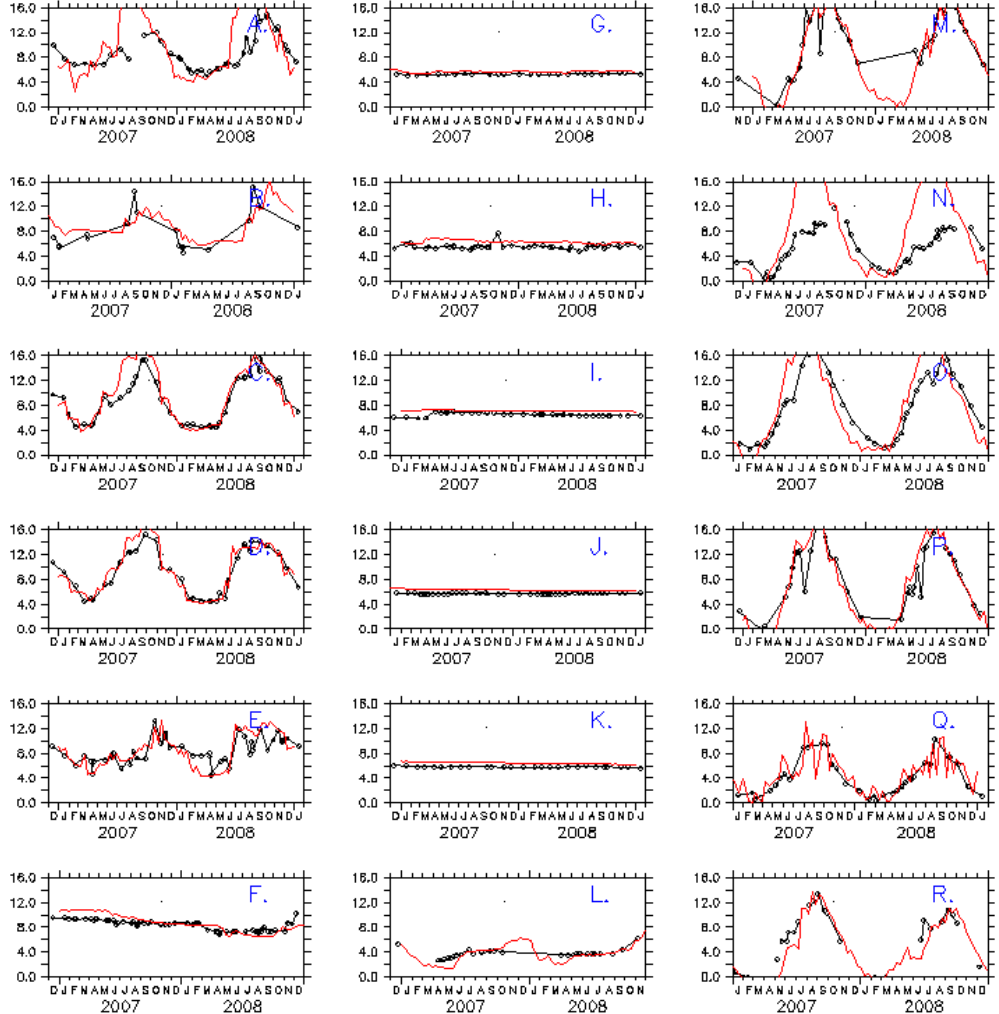
Fig. 3. Seasonal variability of temperature in bottom layer. Notations same as in Fig. 2.